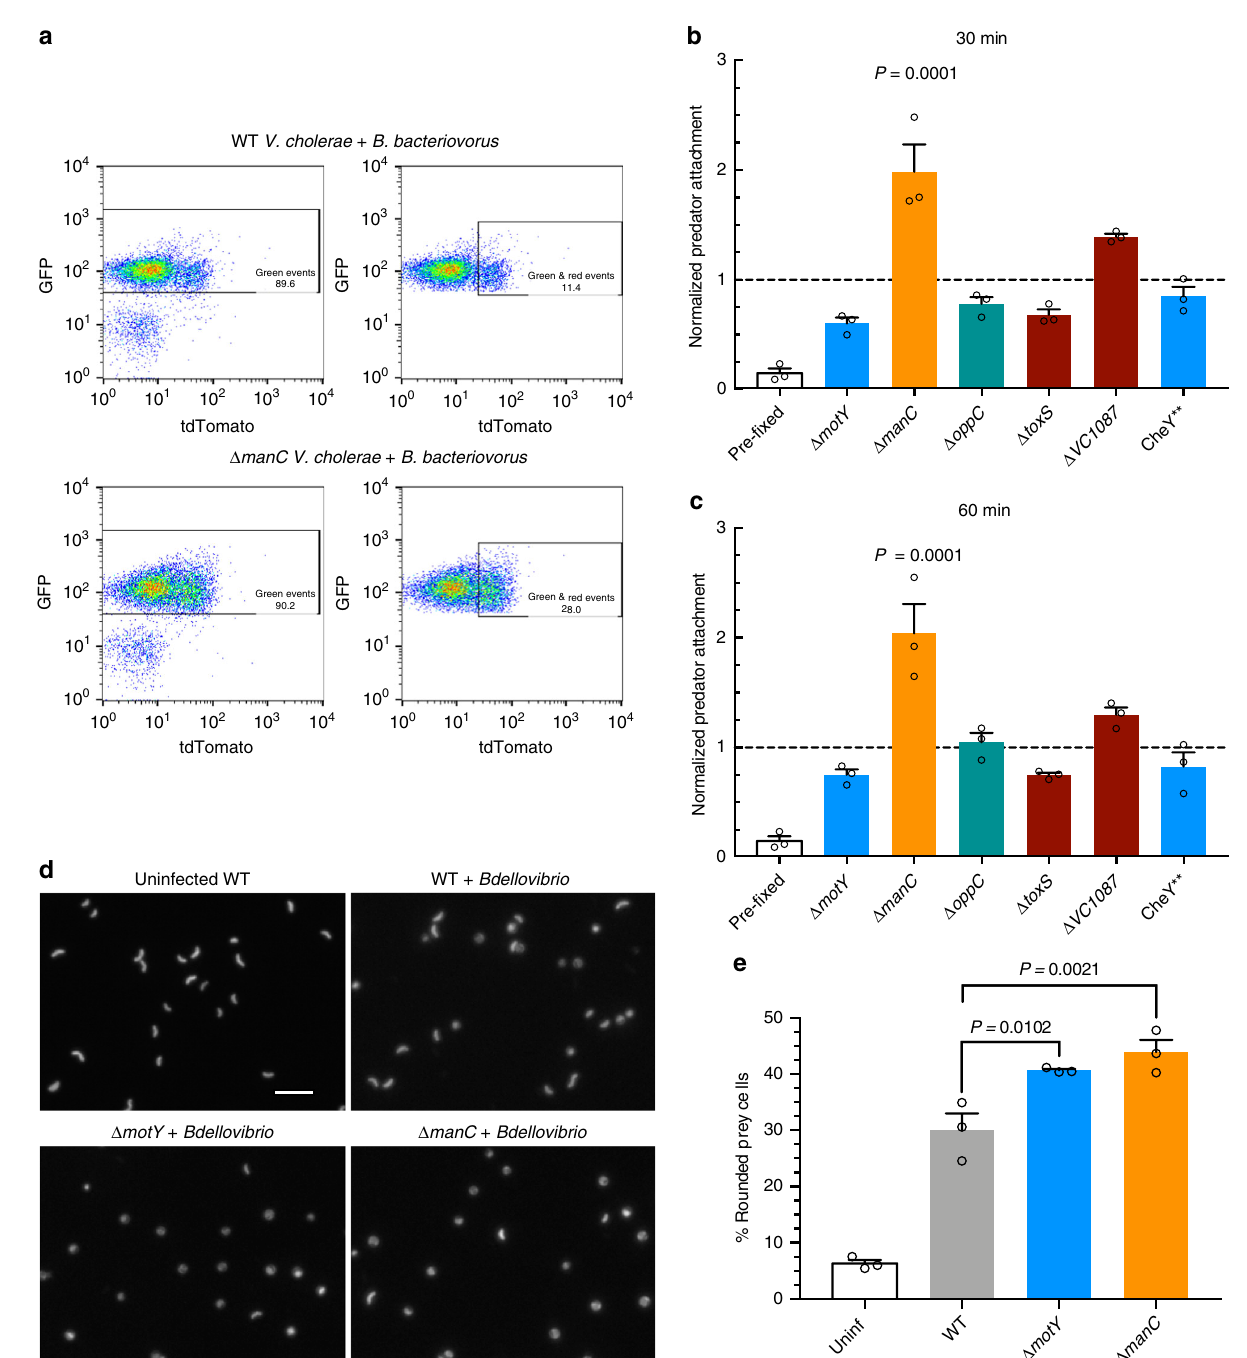
Fig. 3 V. cholerae rounding and attachment by B. bacteriovorus . a Gating strategy for analyzing B. bacteriovorus attachment to V. cholerae by fl ow cytometry. The left plots show all events, while right plots show green-only and double-positive events for the same experiment. b , c Predator attachment to prey by fl ow cytometry at MOI 1 at 30 min ( b ) or 60 min ( c ) post infection. As a control, fl uorescent B. bacteriovorus and V . cholerae were fi xed immediately upon mixing to account for false positive interactions. All attachment to mutant prey was normalized to WT prey attachment for three biological replicates. d Fluorescence images of GFP-expressing V. cholerae 1 h following infection with B. bacteriovorus at MOI 1. The scale bar indicates 10 µ m. e The percentage of rounded V. cholerae cells was calculated by analyzing images by Matlab for roundness (eccentricity) of three biological replicates. Error bars represent standard error of the mean. Statistics were analyzed by ANOVA with Dunnett ’ s multiple comparison ’ s